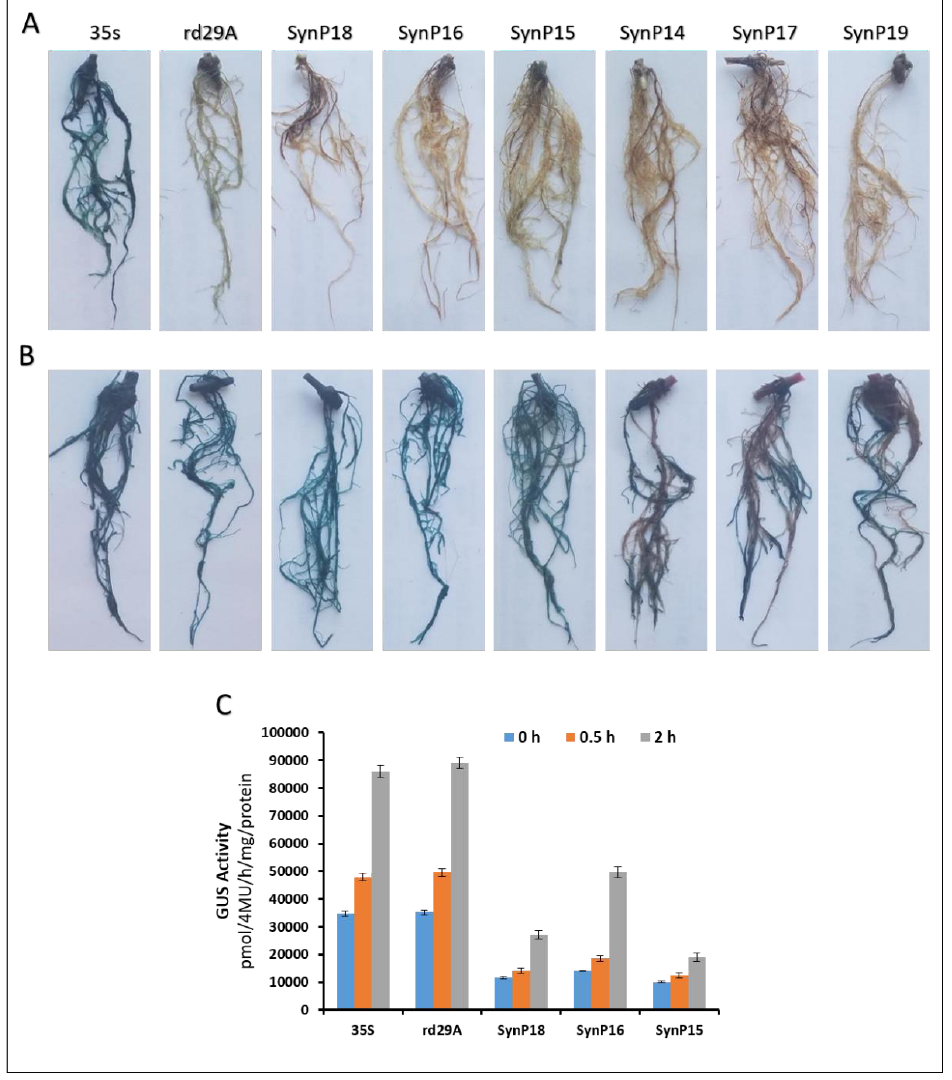
Figure 6. Functional characterization of synthetic promoters in soybean hairy roots. Six synthetic promoters along with control vectors (35S and rd29a as controls) were transformed into soybean via Agrobacterium rhizogenes -mediated transformation. Through GUS histochemical staining of ~10 cm long roots ( A and B ) and Fluorometric Assay of total protein ( C ), the drought-inducibility of expression cassettes was evaluated. GUS staining before ( A ) and after ( B ) drought treatment. ( C ) GUS fluorometric assay for the 3 efficient synthetic promoters with 35S and rd29a as positive controls after drought treatment. As obvious from figures A and B, GUS staining was not very profound in SynP14, SynP17, and SynP19 thus only SynP15, SynP16, and SynP18 were proceeded to GUS quantification. Hairy roots shown here are of ~30 days old soybean plants.